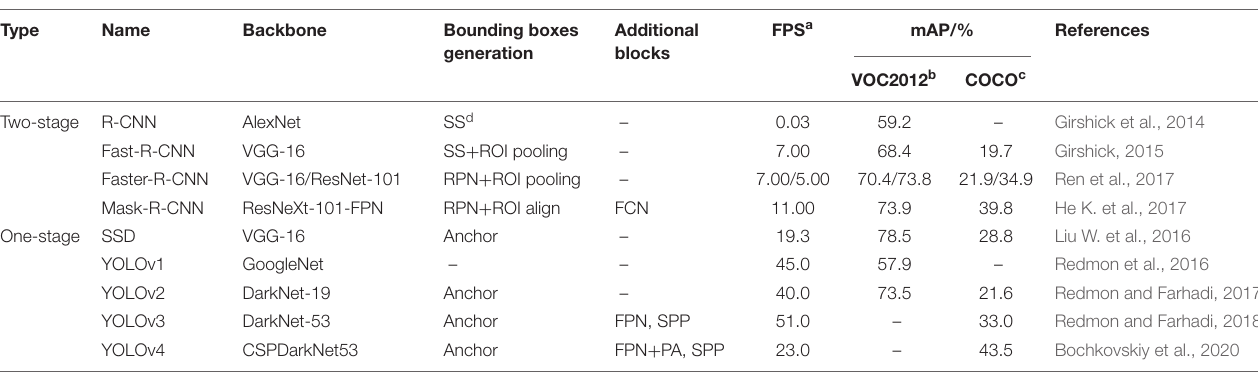
FIGURE 3 | Faster-R-CNN structure. The feature map is extracted by a convolutional neural network, and then the RPN (region proposal network) generates several accurate region proposals according to the feature map. The region proposals are mapped to the feature map. The ROI (region of interest) pooling layer is responsible for collecting proposal boxes and calculating proposal feature maps. Finally, the category of each proposal is predicted through the FC (full connect) layer. TABLE 2 | Summary of common CNN-based object detection